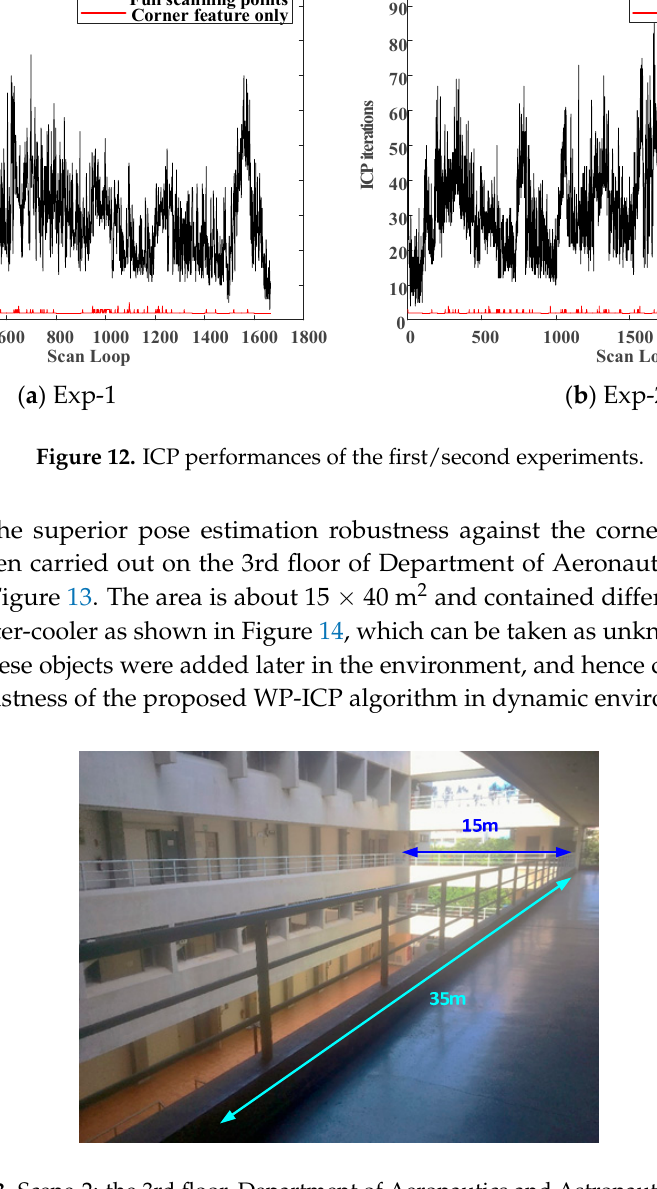
Figure 13. Scene-2: the 3rd floor, Department of Aeronautics and Astronautics, NCKU.